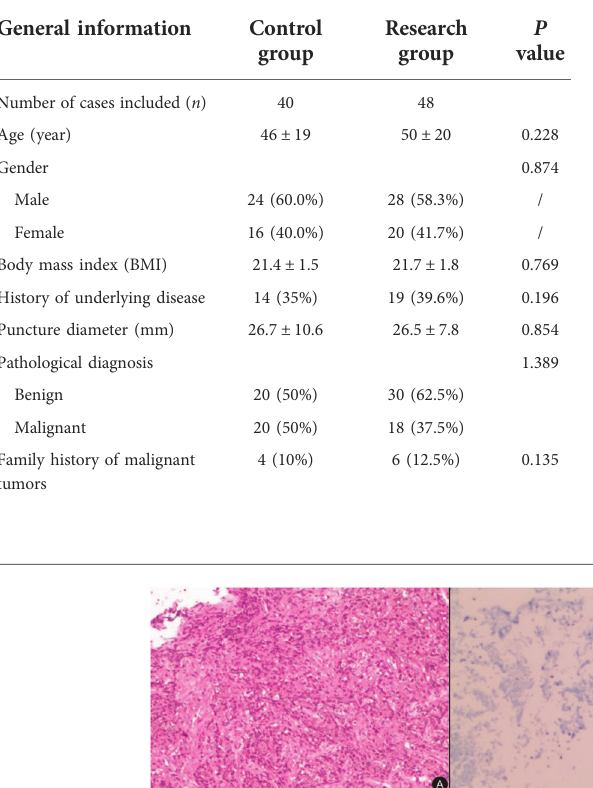
TABLE 1 General data of patients included in the study.